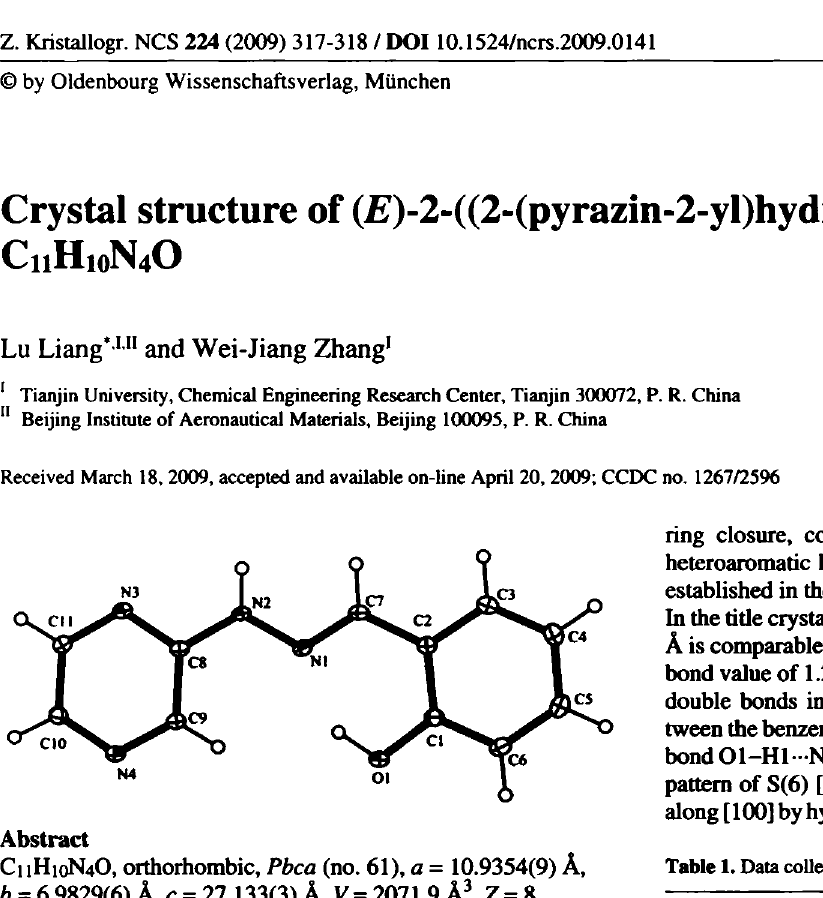
Table 1. Data collection and handling.